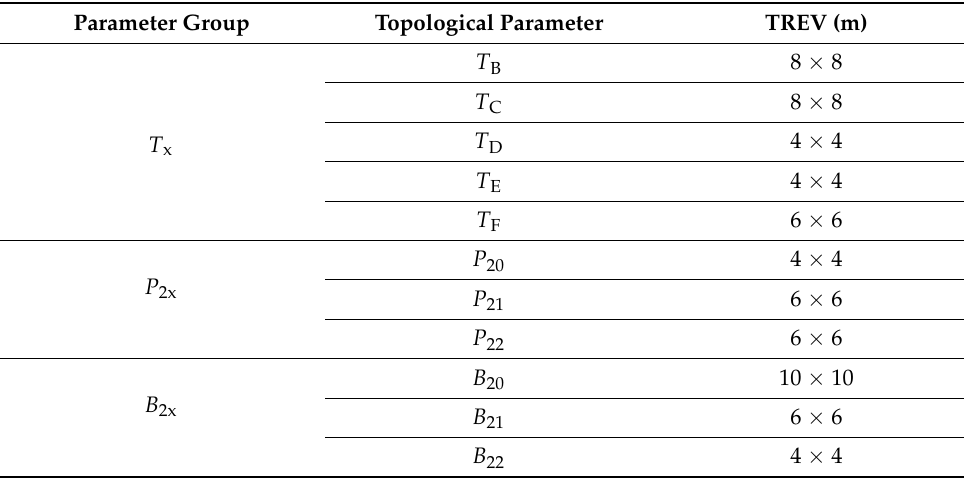
Table 2. TREV of fractured rock mass for different equivalent